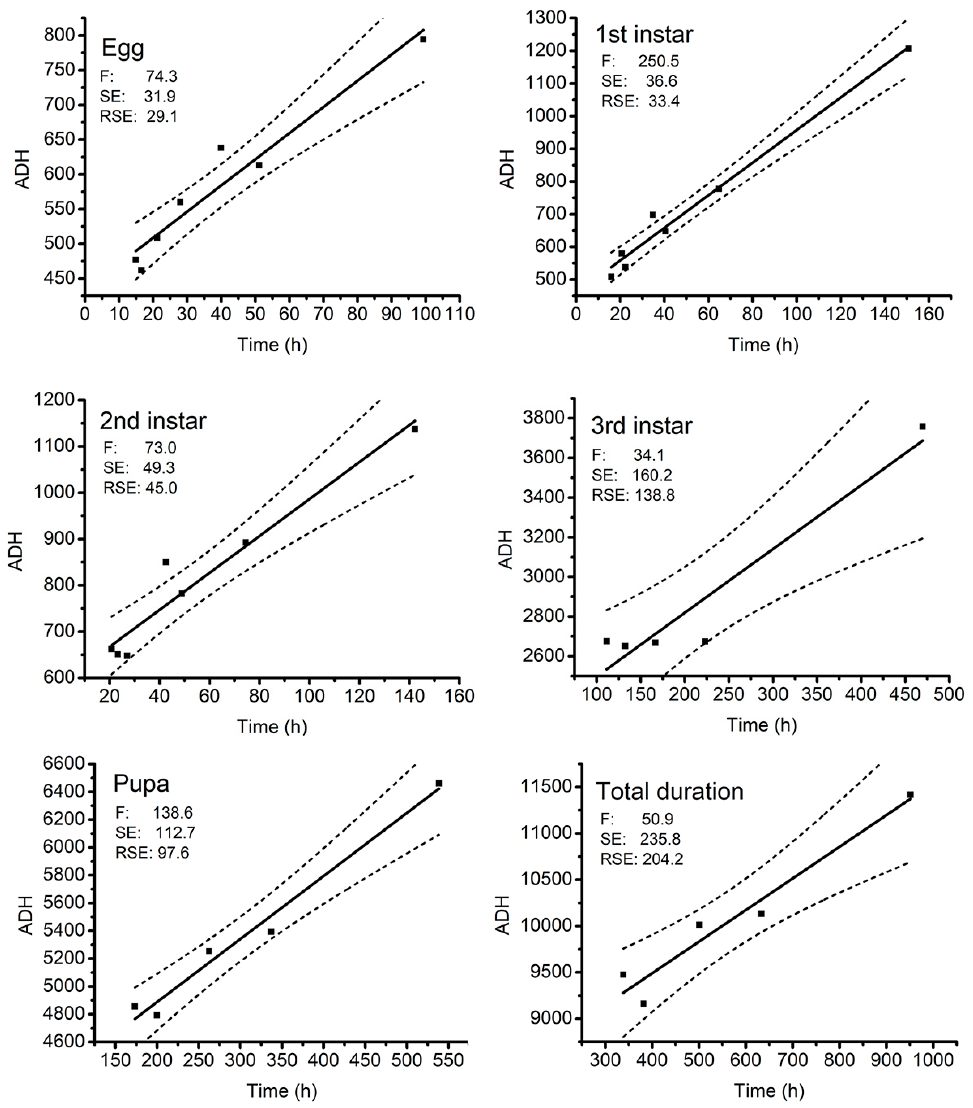
Figure 4. Thermal summation models of total developmental stages of A. grahami . represents the 95% confidence interval. F, SE, RSE respectively represent F statistic, standard error, residual standard error.